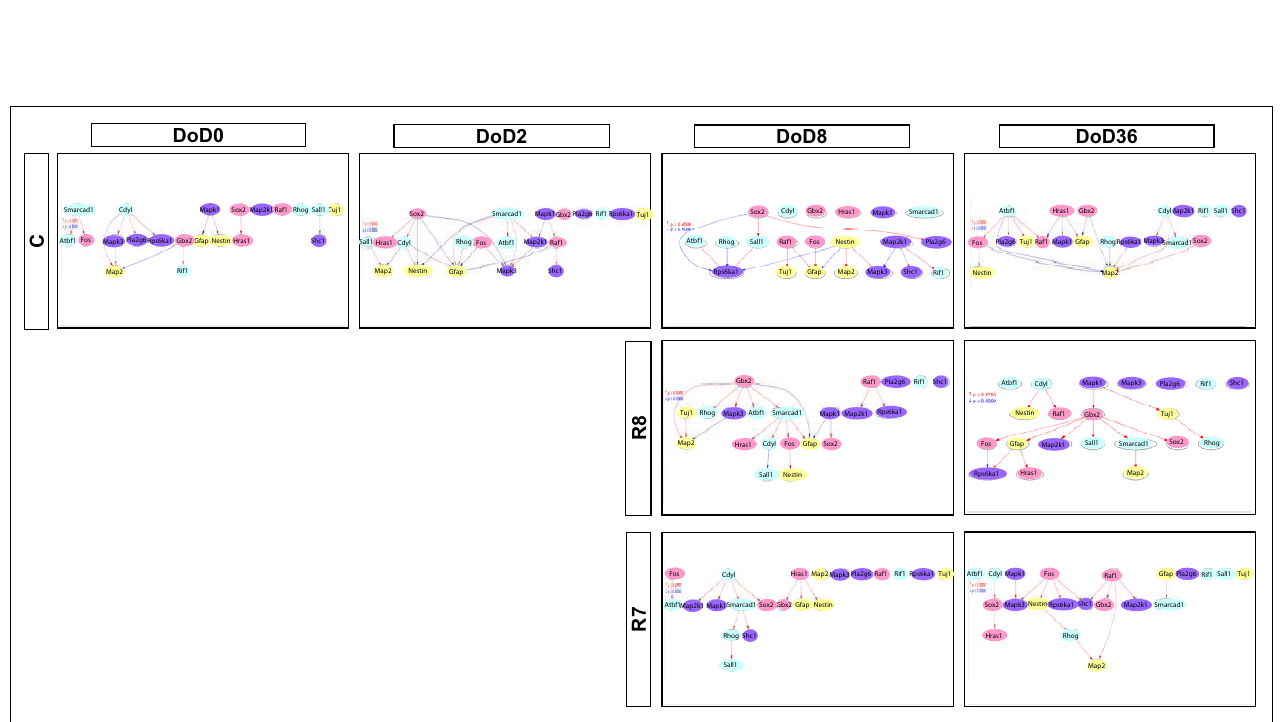
FIGUREA2 | Gene interaction networks of the analysis-based gene set (set 2) in mESCs, EB, and NP of neuronal differentiation. The optimized network was generated at p > 0.300. Red indicates that parent genes up-regulate children genes. Blue indicates that parent genes down-regulate children